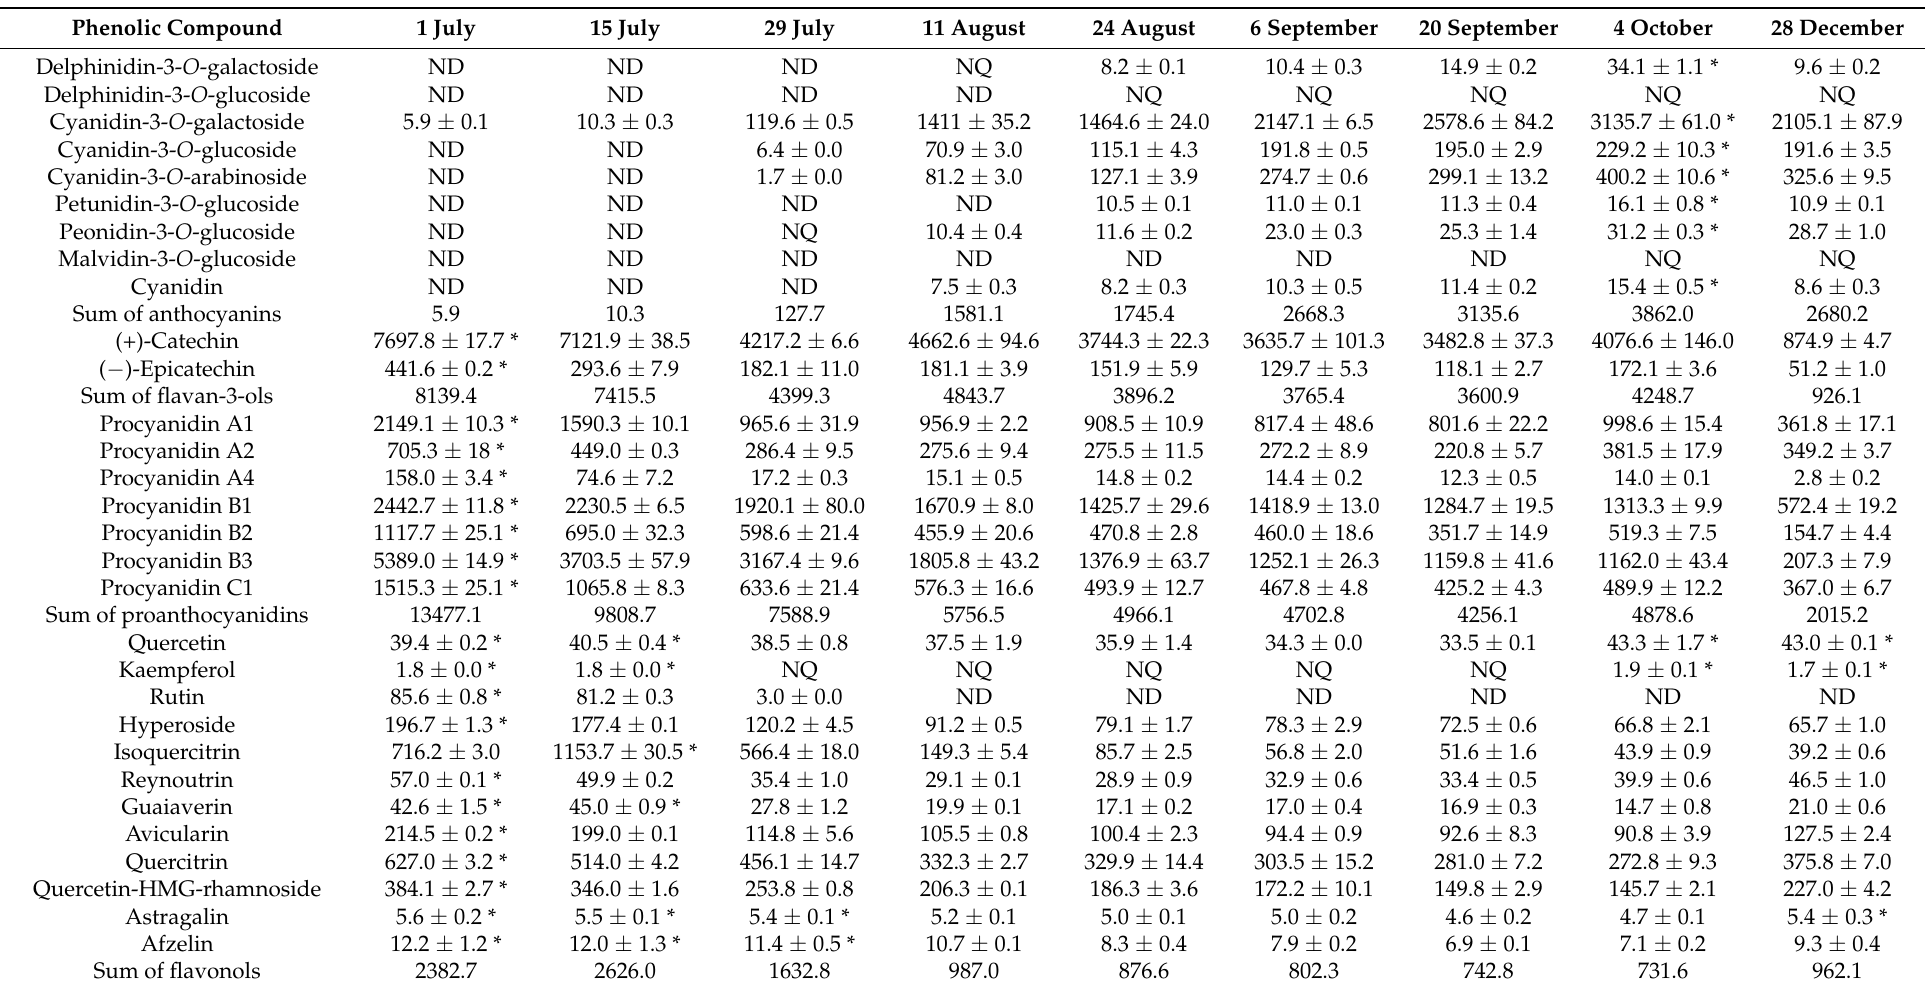
Table 2. Contents of phenolics ( µ g/g DW ± SD) in lingonberries during different phenological stages. Values marked with * in the same row indicate the highest ( p < 0.05) amounts in samples. ND—not detected, NQ—not